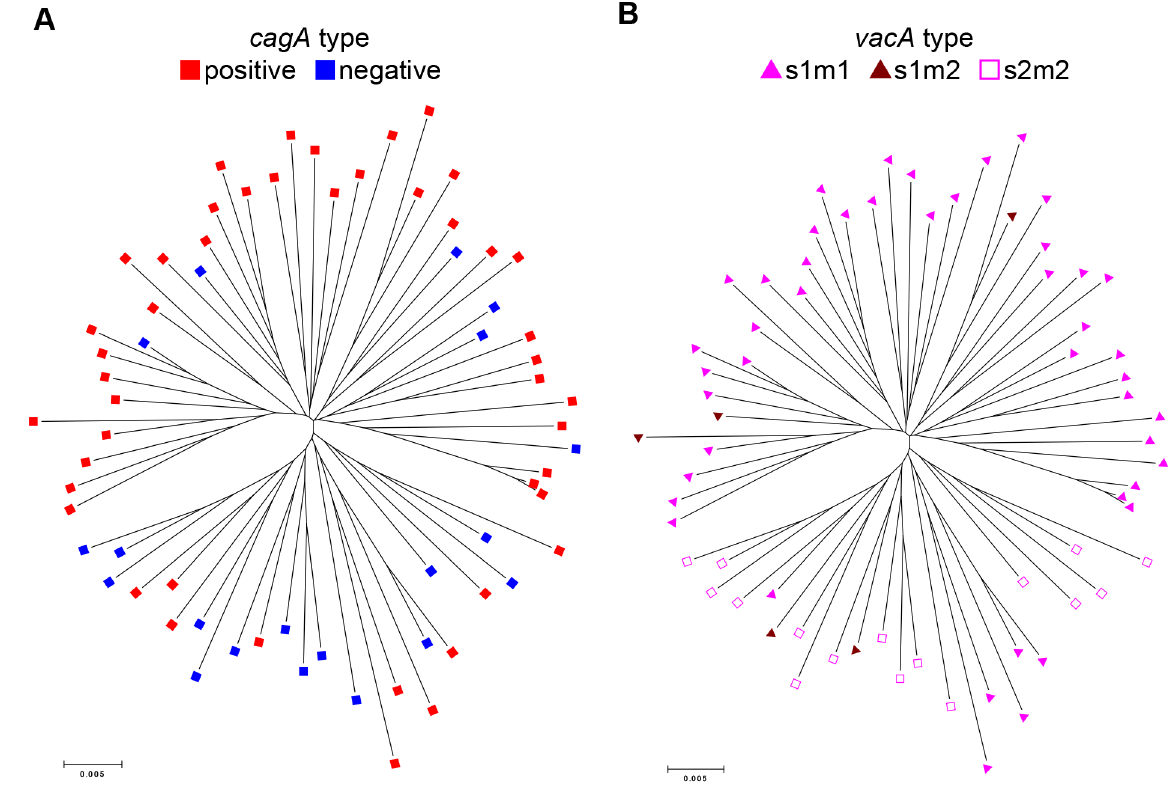
Figure 2. The status of cagA (a) and vacA (b) mapped on the MLST tree.